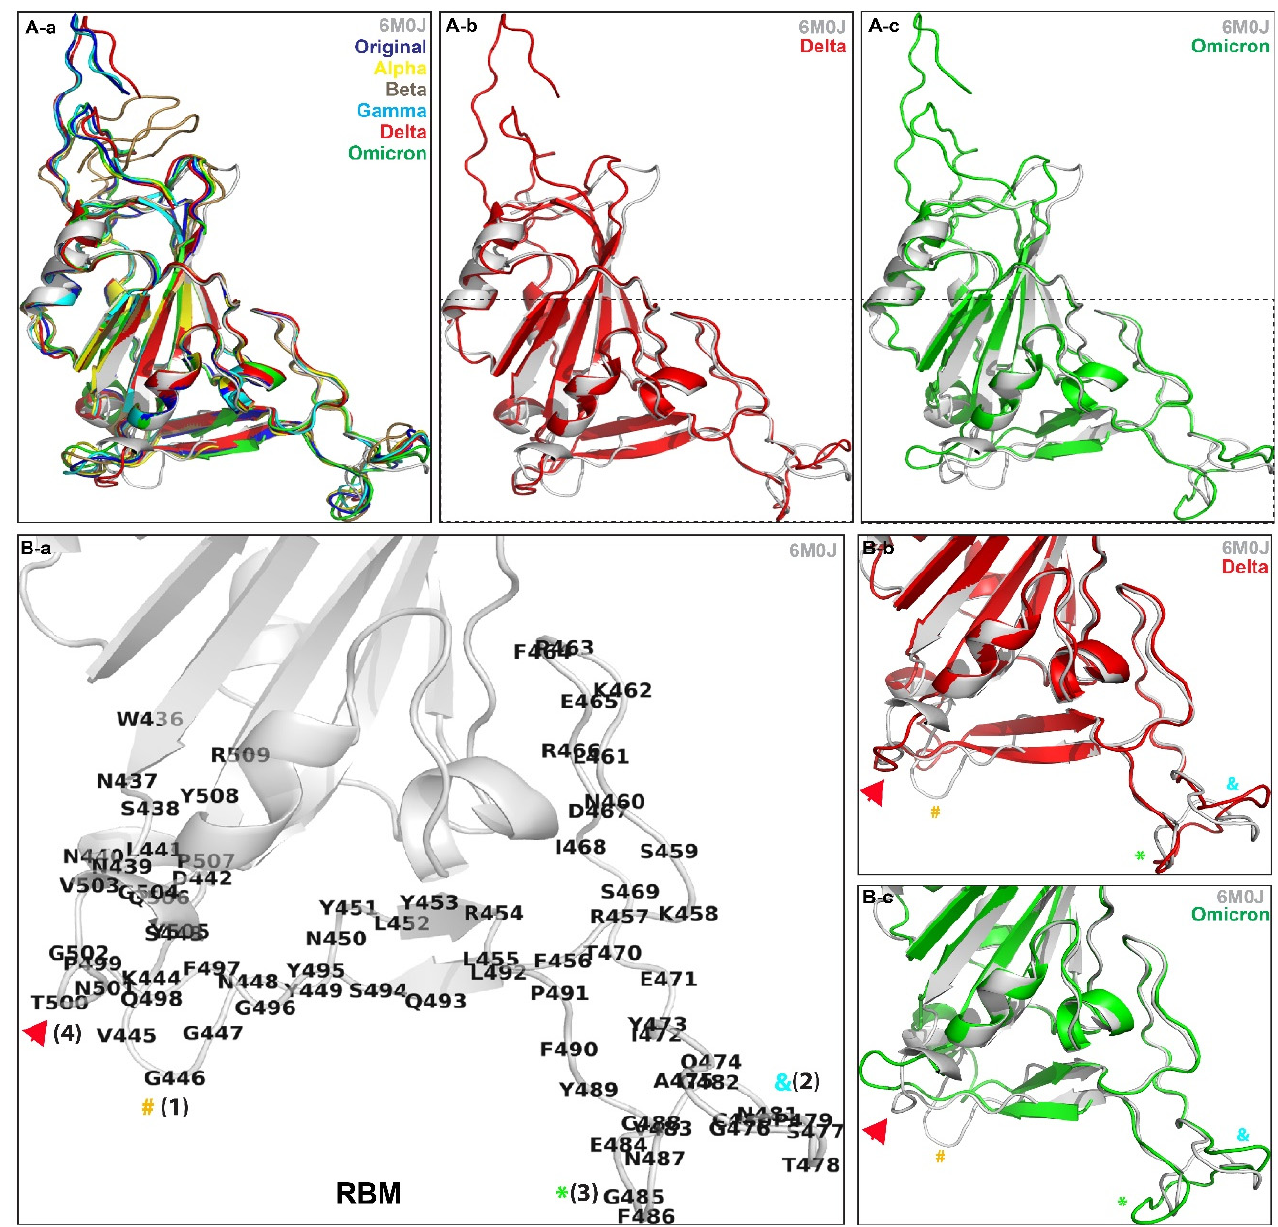
Figure 1. ( A-a ) All the trRosetta-generated Receptor-Binding Domain (RBD) structures were super- imposed on 6M0J. ( A-b ) Structural changes between the RBM of 6M0J and the Delta sequence. ( A-c ) Structural changes of the RBM between 6M0J and the Omicron sequence. ( B-a ) RBM of 6M0J; (1), (2), (3), (4) are the changes observed. ( B-b ) Structural changes of the RBM between 6M0J and the Delta sequence. ( B-c ) Structural changes of the RBM between 6M0J and the Omicron sequence. Table 1. RMSD (root mean square deviation of atomic positions) score for both trRosetta-generated and AlphaFold-generated RBD models superimposed on PDB: 6M0J. The root-mean-square devia- tion of atomic positions is the measure of the average distance (Å) between the atoms of superim- posed proteins.